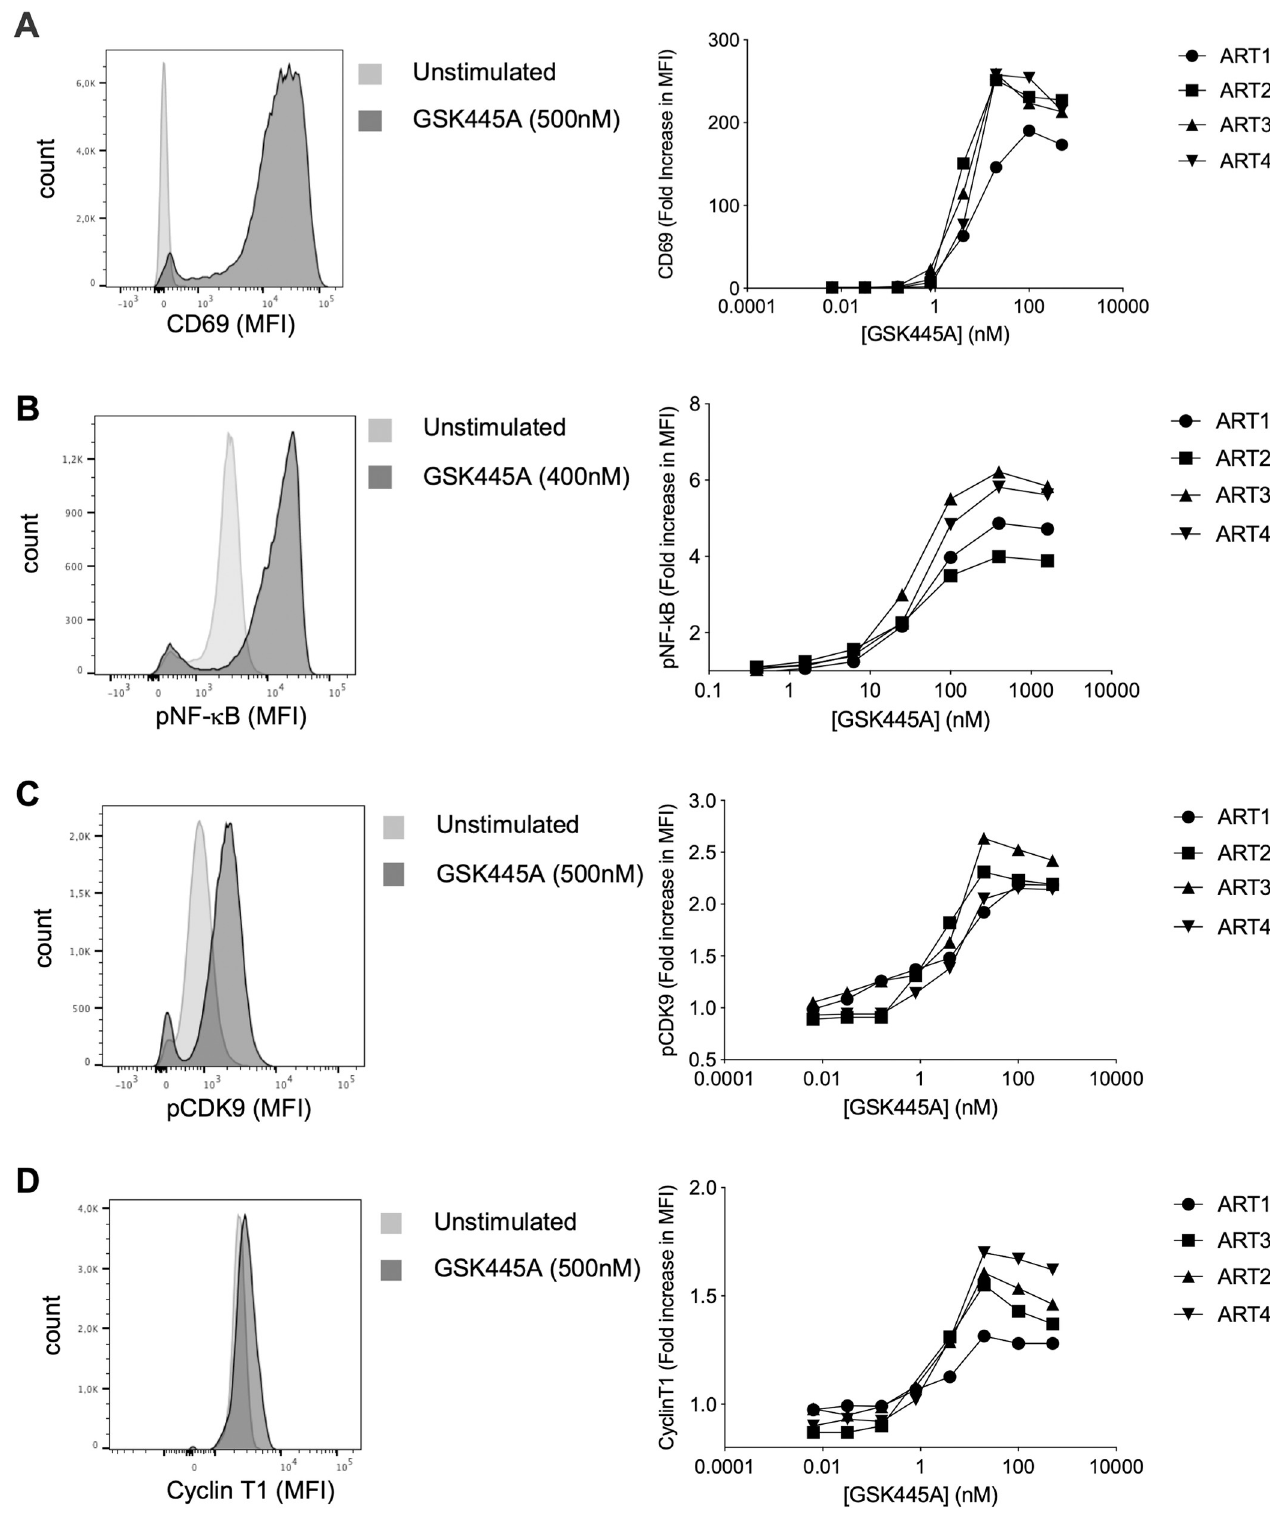
Fig 1. GSK445A induces cellular factors associated with HIV latency reversal. Expressions of cell surface CD69 (A), intracellular p-NF κ B (pS529) (B), intracellular pCDK9 (pS175) and (C) intracellular cyclin T1 (D) following stimulation with increasing doses of GSK445A were measured by flow cytometry in CD4 + T cells from 4 HIV-infected and virally suppressed individuals. Representative histograms (left panels) and dose response curves (right panels) are shown. https://doi.org/10.1371/journal.ppat.1010245.g001 PLOS Pathogens| https://doi.org/10.1371/journal.ppat.1010245 January18, 2022 4 /